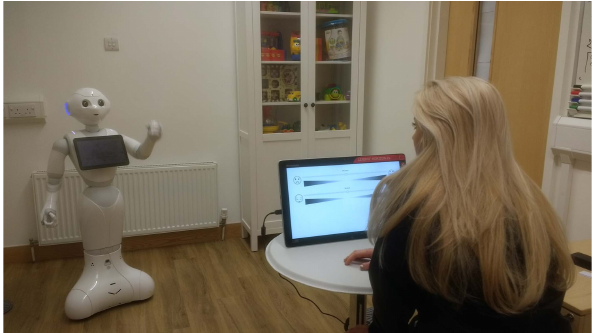
Figure 2: The experimental